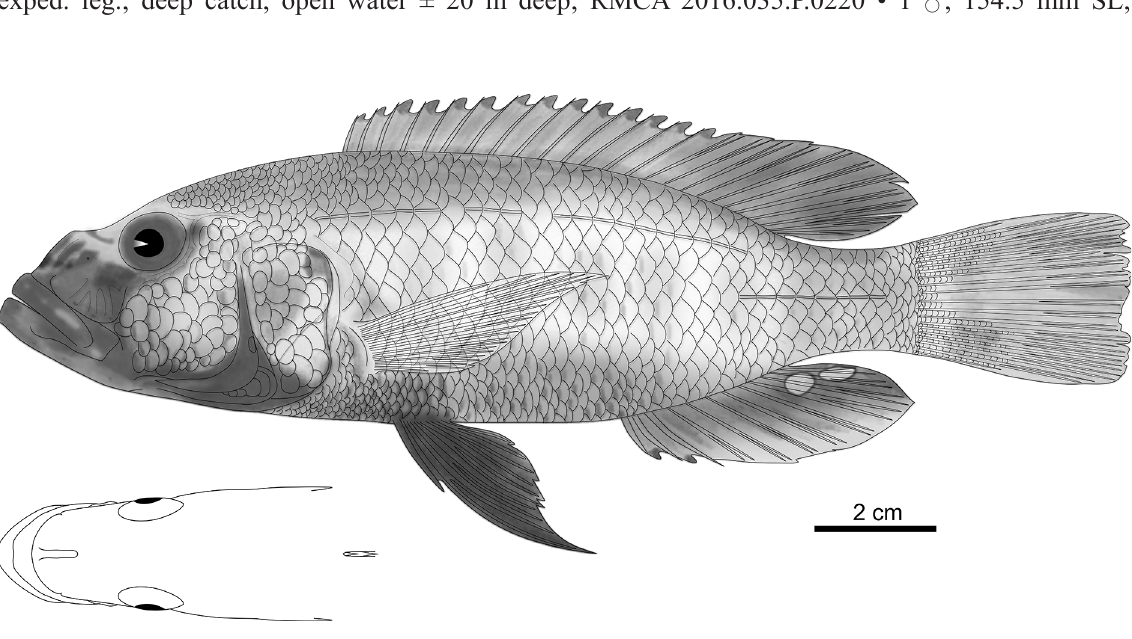
Fig. 11. Haplochromis rex sp. nov., holotype, ♂, 148.5 mm SL (RMCA 2018.008.P.0345). Drawn by N.